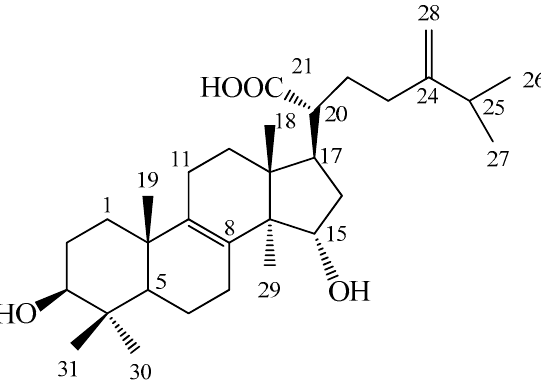
Figure 1. Chemical structure of sulphurenic acid (SA).